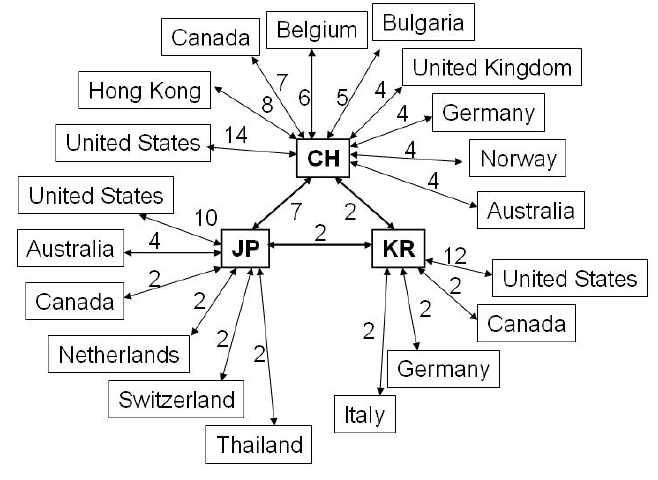
Figure 9. International collaboration map for China, Japan and Korea in the period